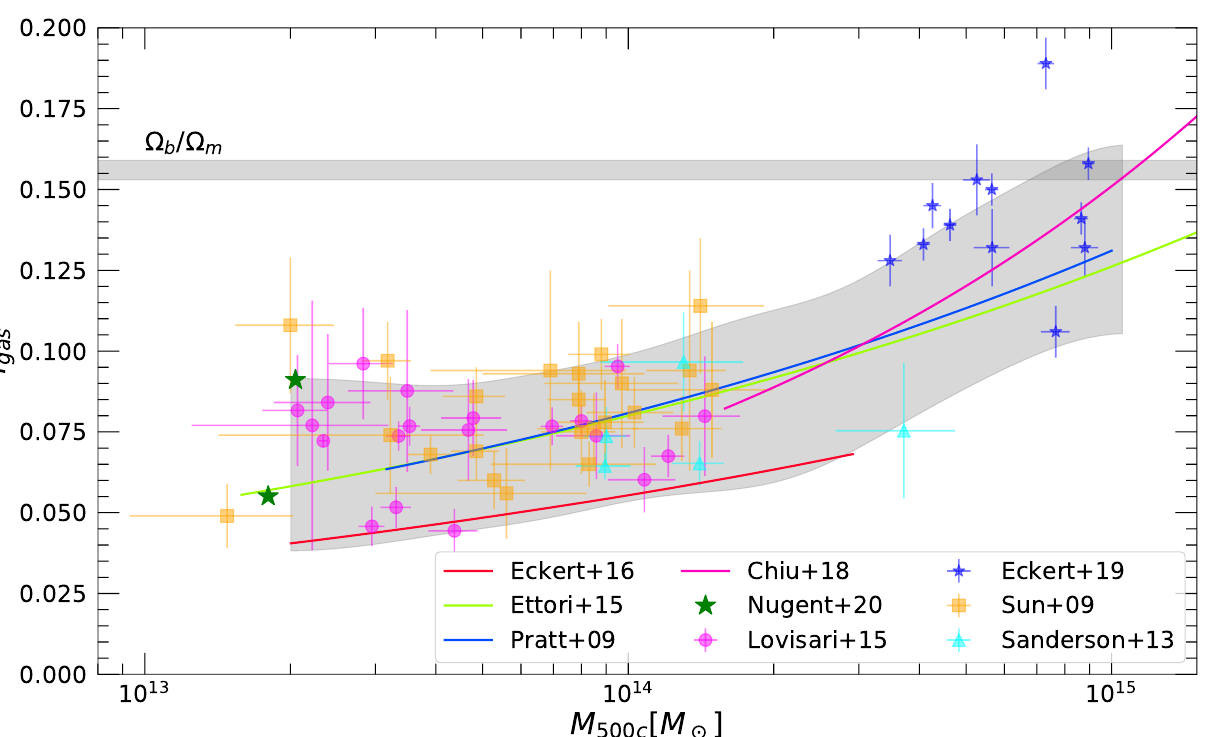
Figure 7. Compilation of existing measurements of the hot gas fraction at R 500 in galaxy groups and clusters as a function of halo mass M 500 . The data points show the galaxy group samples of Sun et al. [137] (orange), Lovisari et al. [174] (magenta), Sanderson et al. [181] (cyan), and Nugent et al. [177] (green). The data from the X-COP sample [169] at the high-mass end are shown as the blue points for comparison. The solid lines show the f gas − M relations that are derived from REXCESS (blue, [173]), XMM-XXL (red, [175]), SPT-SZ (magenta, [180]), and the literature sample of Ettori [176]. The gray shaded area shows the 90% confidence range encompassing the existing observational data and their corresponding uncertainties (see